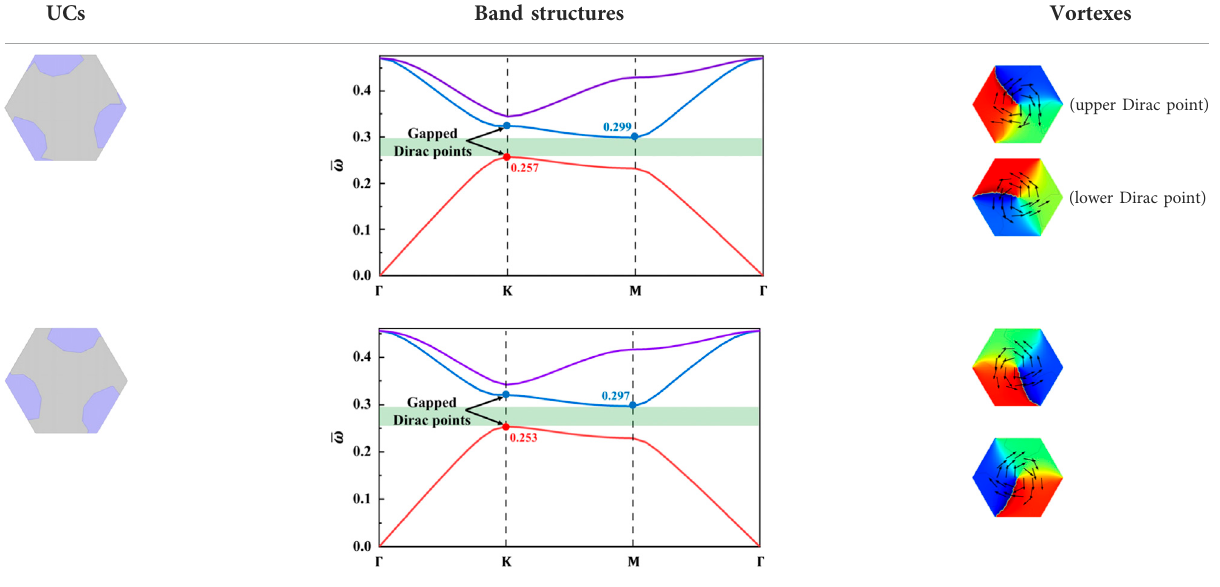
TABLE 1 The optimized topological insulators with a normalized common bandgap of 0.04, their band structures and the energy vortexes of the gapped Dirac points. UCs Band